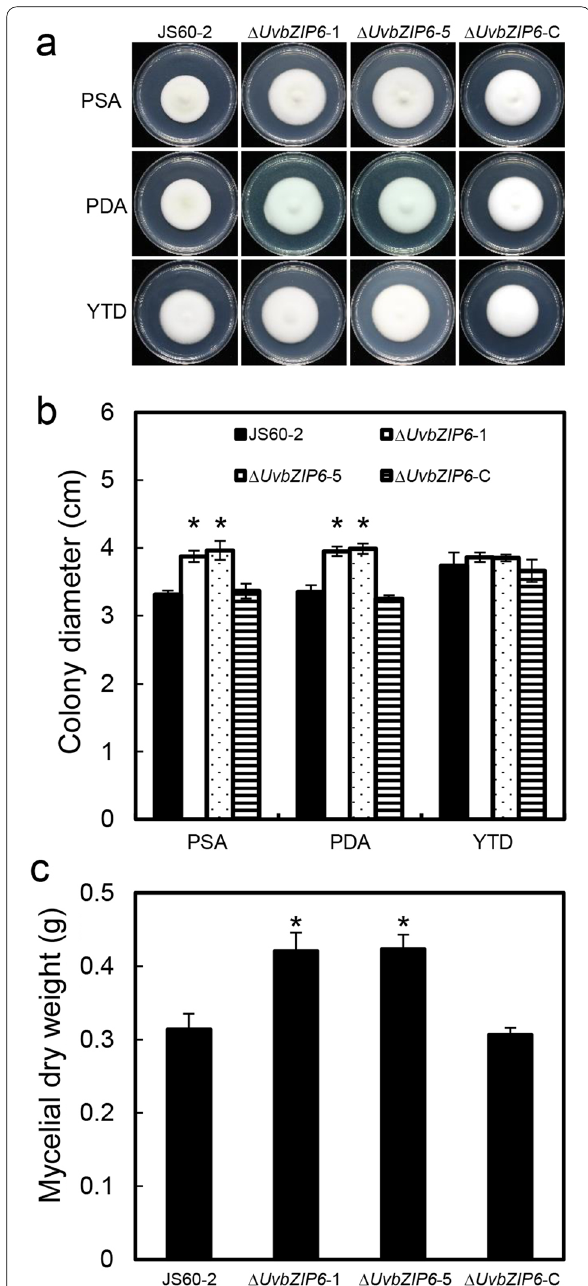
Fig. 3 Knockout of UvbZIP6 enhances the vegetative growth of U. virens . a Colony morphology of U. virens strains on PSA, PDA, and YTD. The WT, UvbZIP6- knockout mutants, and complemented strains were incubated on the medium at 27 °C for 14 days. b Colony diameter of U. virens strains on different media. c Mycelia dry weight of the tested strains. The mycelia were collected and dried after incubation in PSB at 27 °C for 7 days. The error bars represent the standard deviation, and asterisks represent a significant difference ( P <